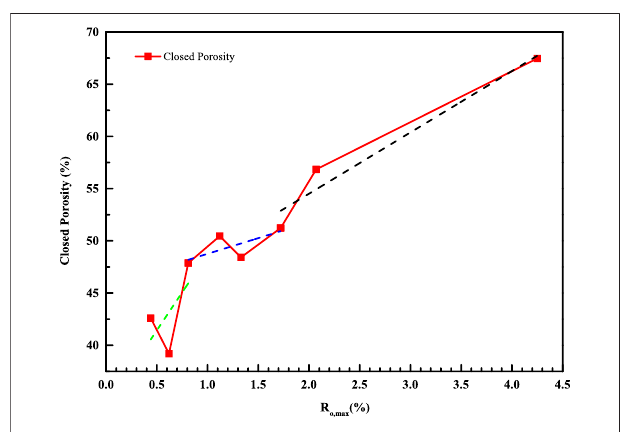
FIGURE 8 | Variation of closed porosity of samples with coal